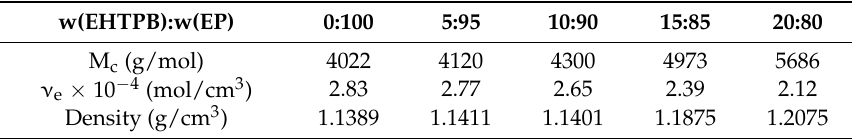
Table 4. M c , crosslink density and density of the modified epoxy resin with different w(EHTPB)/ w(EP)